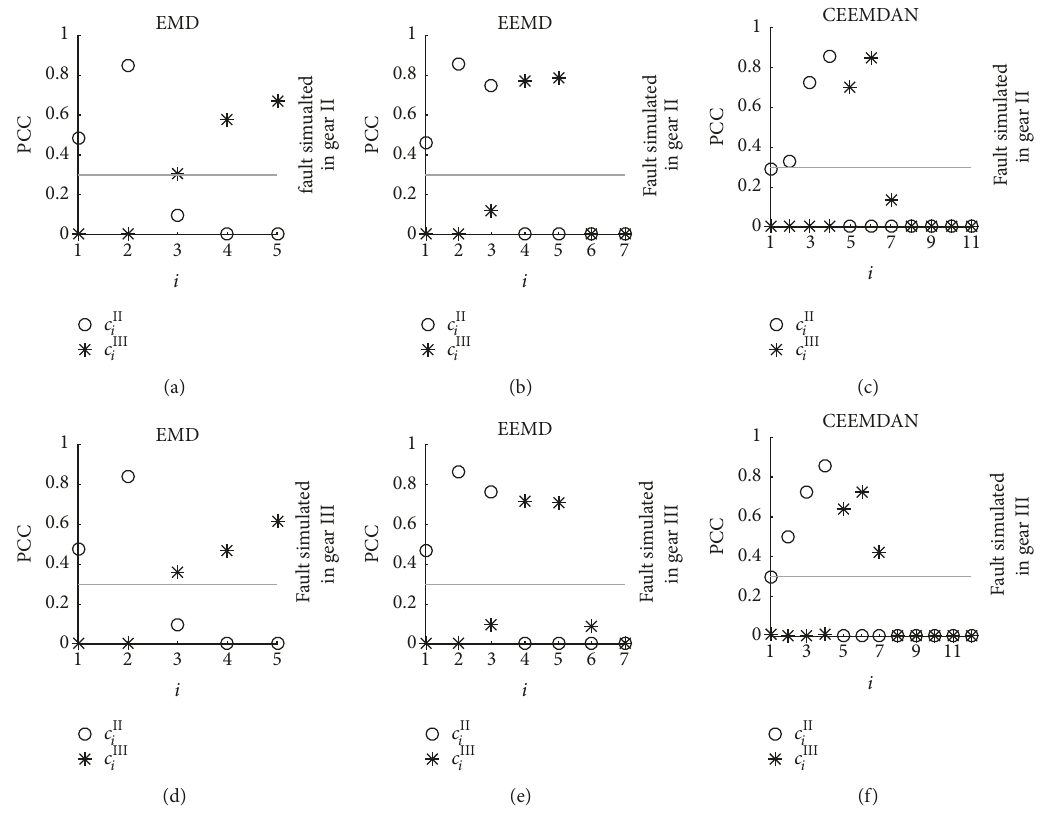
Figure 9: PCC values (a–c) in the case of the simulated signal with localized fault in gear II and (d-e) in the case of the simulated signal with localized fault in gear III.